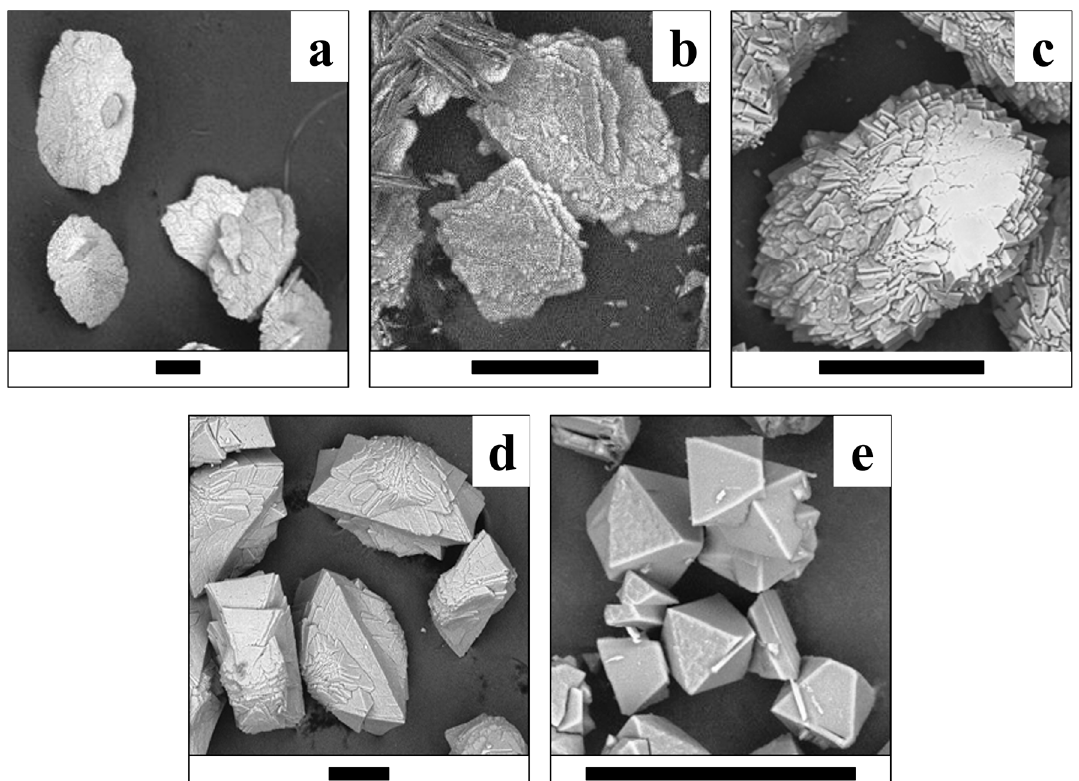
Figure 9. Crystals of (Mg,Mn) C 2 O 4 ∙ 2H 2 O solid solutions (S series) obtained at various Mg/(Mg + Mn) ratios in solution. ( a )—0%; ( b )–30%; ( c )–70%; ( d )—80%; ( e ) − 100%. Black bar is 100 μ m.